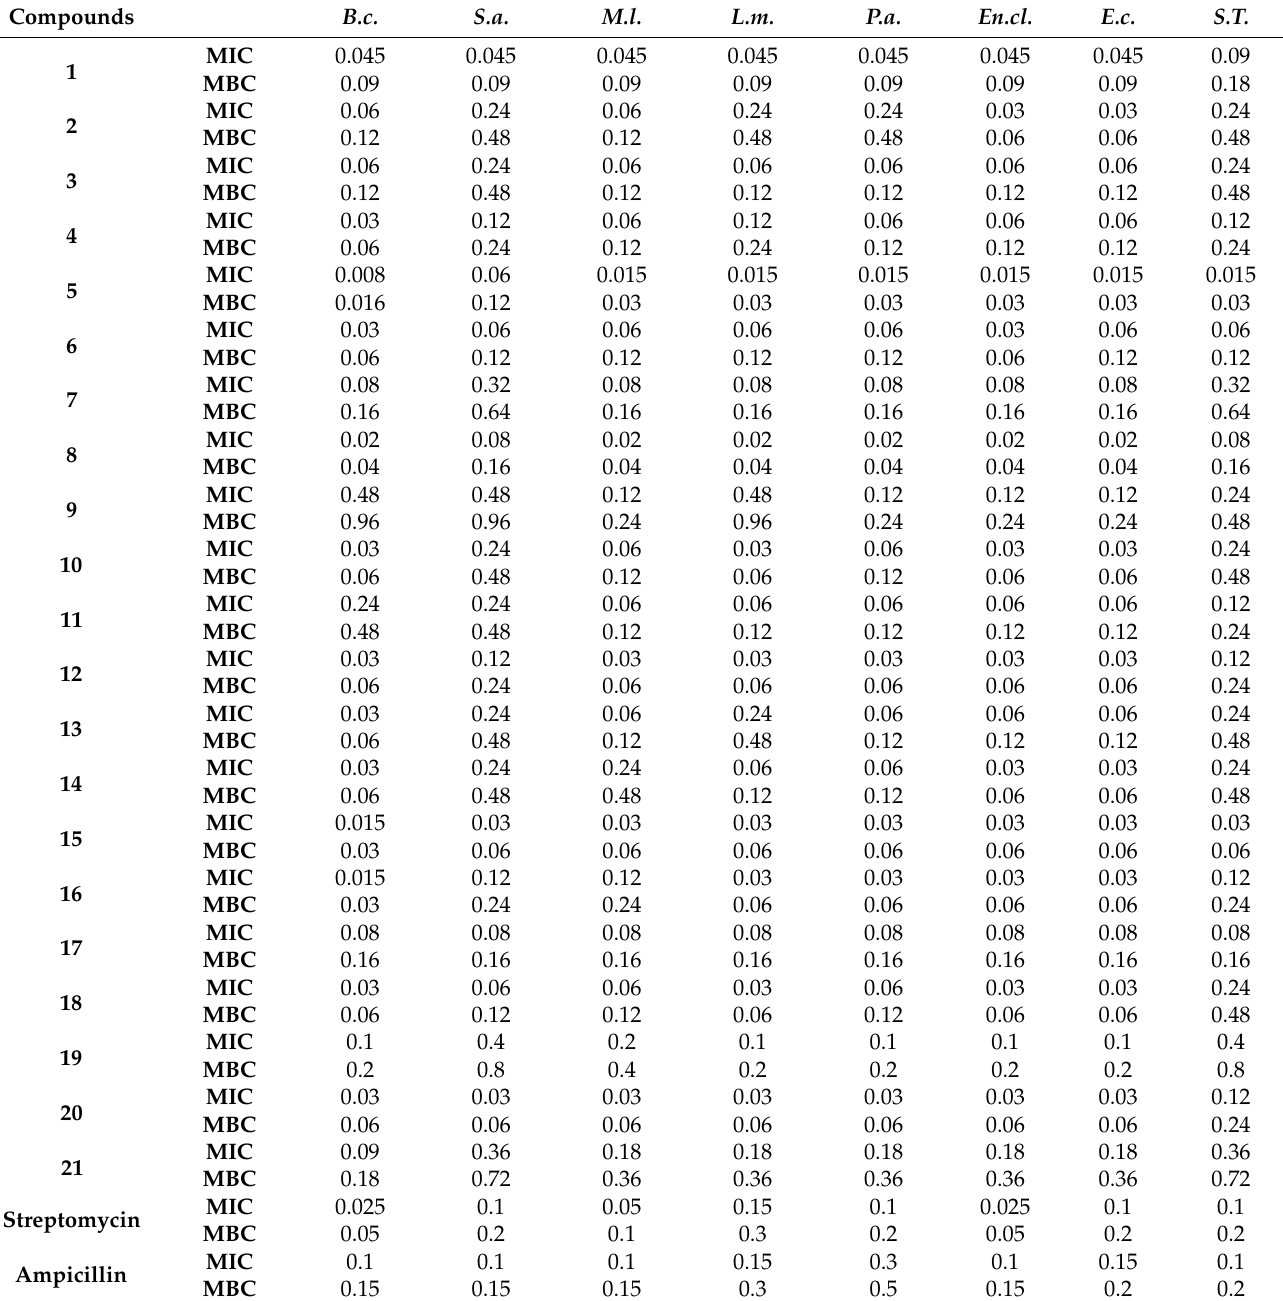
Table 1. Antibacterial activity of compounds (MIC/MBC in